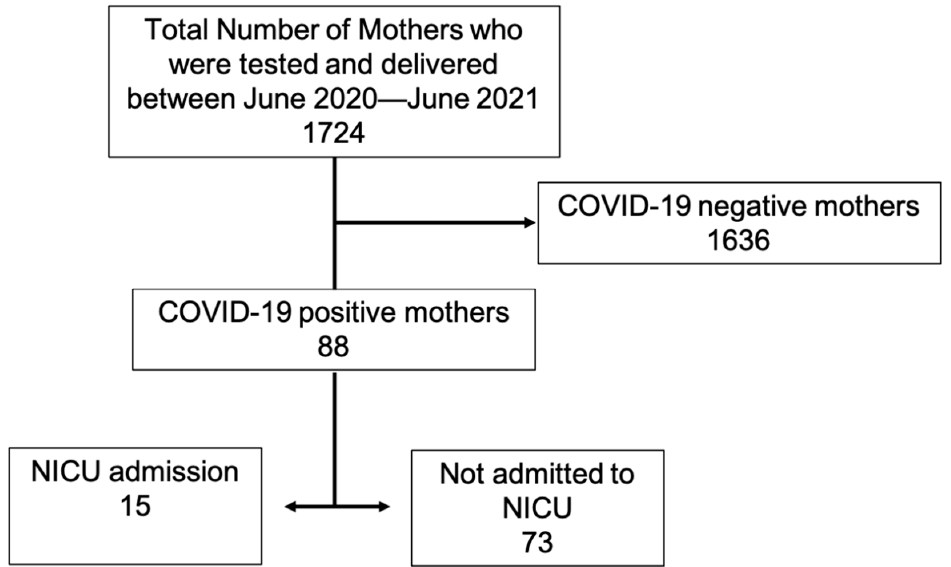
Figure 1. Distribution of patients.